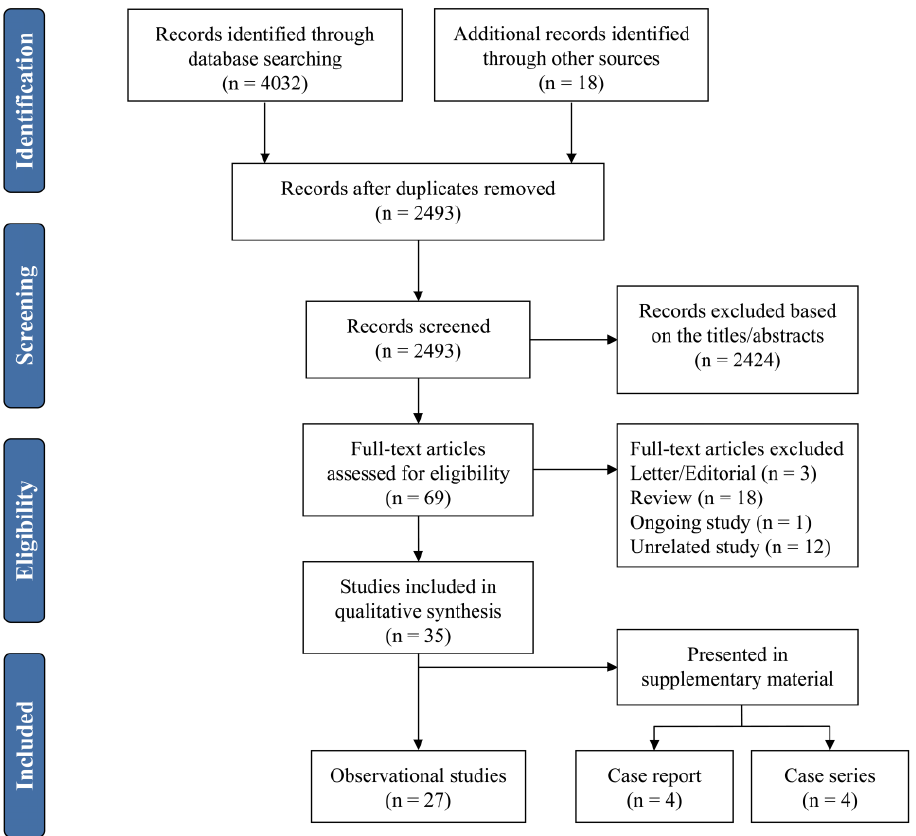
Figure 1. PRISMA flow diagram.